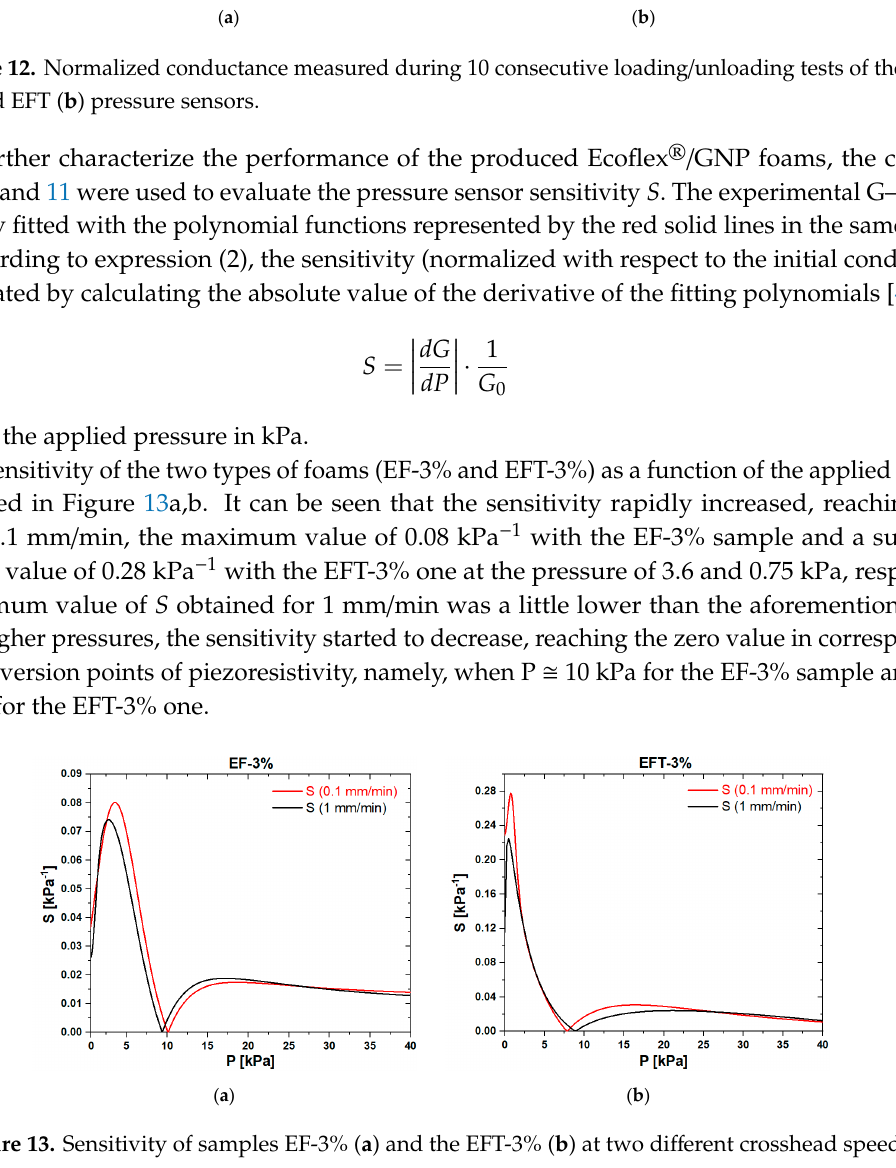
Figure 12. Normalized conductance measured during 10 consecutive loading/unloading tests of the EF ( a ) and EFT ( b ) pressure sensors.